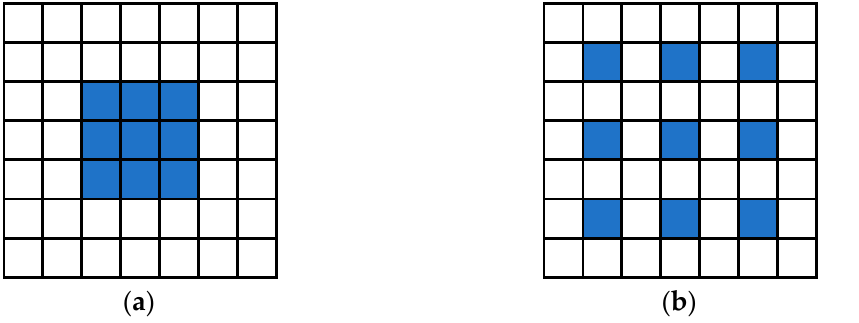
Figure 7. Schematic of the dilated convolutional kernel: ( a ) dilated rate equal to 1 ( b ) dilated rate equal to 2.